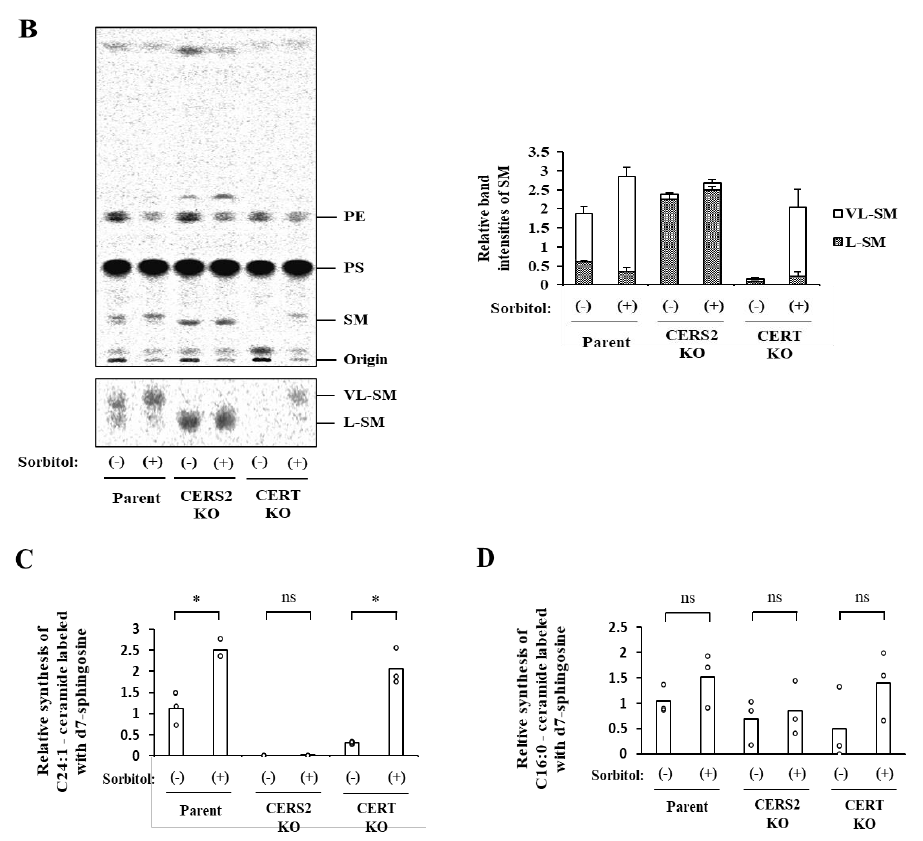
Figure 4. Effects of hyperosmotic stress on SM biosynthesis. ( A ) HeLa CERT KO cell lines stably expressing various mVenus-CERT variants were labeled with [ 14 C]-serine/800 mM sorbitol-containing medium or isotonic medium for 1 h. Lipids extracted from the cells were separated by TLC using the buffer (methyl acetate/1-propanol/chloroform/methanol/0.25% KCl — 50/50/50/20/18, vol/vol). A representative radioactive image of the analyzed TLC plates is shown. Relative band intensities of SM were calculated as described in Section 4. White bars in the graph represent the mean (n = 4), and the white circles indicate the values from each experiment. *: p < 0.05 (Student’s t -test). PtdEtn, phosphatidylethanolamine; PtdSer, phosphatidylserine; SM, sphingomyelin. ( B ) Metabolic labeling analysis was performed in CERS2 KO cells as described in (A). The upper panel shows the whole TLC image. The lower panel shows the vertically magnified image of SM of the upper panel to discern the doublet patterns. The open and filled bars indicate the relative band intensities of very-long-chain SM (VL-SM) and long-chain SM (L-SM), respectively. Data are presented as the mean ± SD (n = 3). ( C , D ) Effects of hyperosmotic stress on CERS2 activity. Following exposure of the indicated cells to the isotonic control or hyperosmotic conditions, a membrane fraction was prepared from the cells. The membrane fraction was incubated with d7-sphingosine in the presence of C24:1-acyl CoA or C16:0-acyl CoA for 30 min at 37 °C. Then, the quantities of d7-sphingosine-labeled C24:1-ceramide ( C ) and C16:0-ceramide ( D ) synthesized were determined by LC – MS. The relative levels of synthesis of d7-sphingosine-labeled ceramides were calculated as described in Section 4. Data are presented as the means (n = 3), and the white circles indicate the values from each experiment. *: p < 0.05 (Student’s t -test).